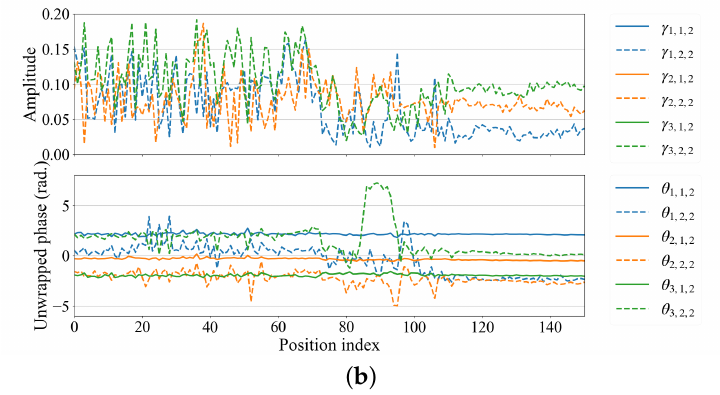
Figure 15. Features of the conference room. ( a ) Features of Tx1. ( b ) Features of Tx2.